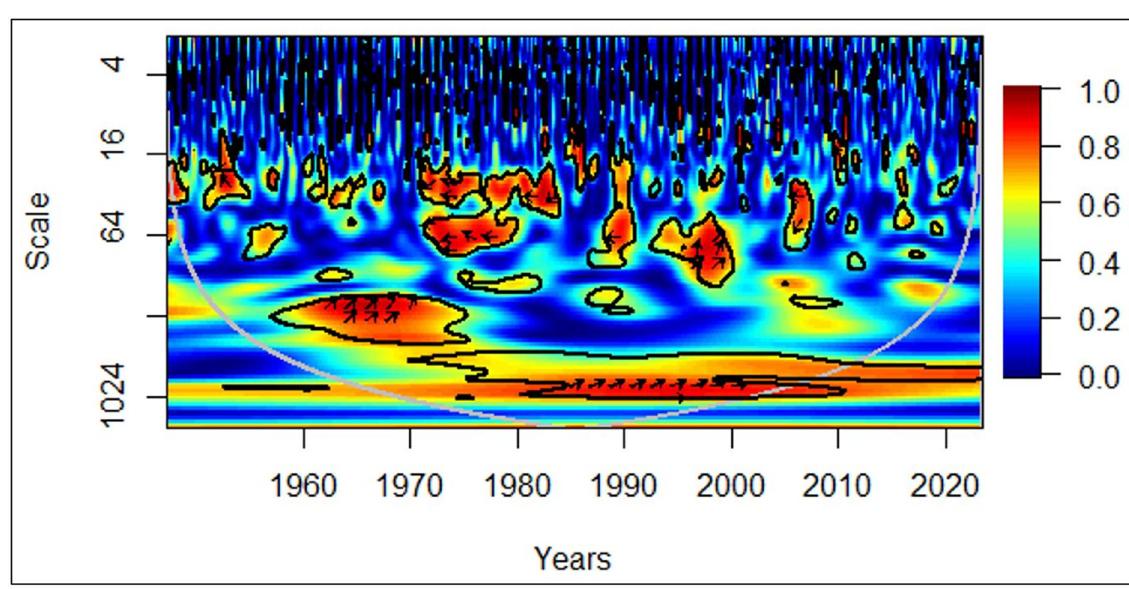
Fig 4. All countries: GDP vs EPOP. Source: Authors’